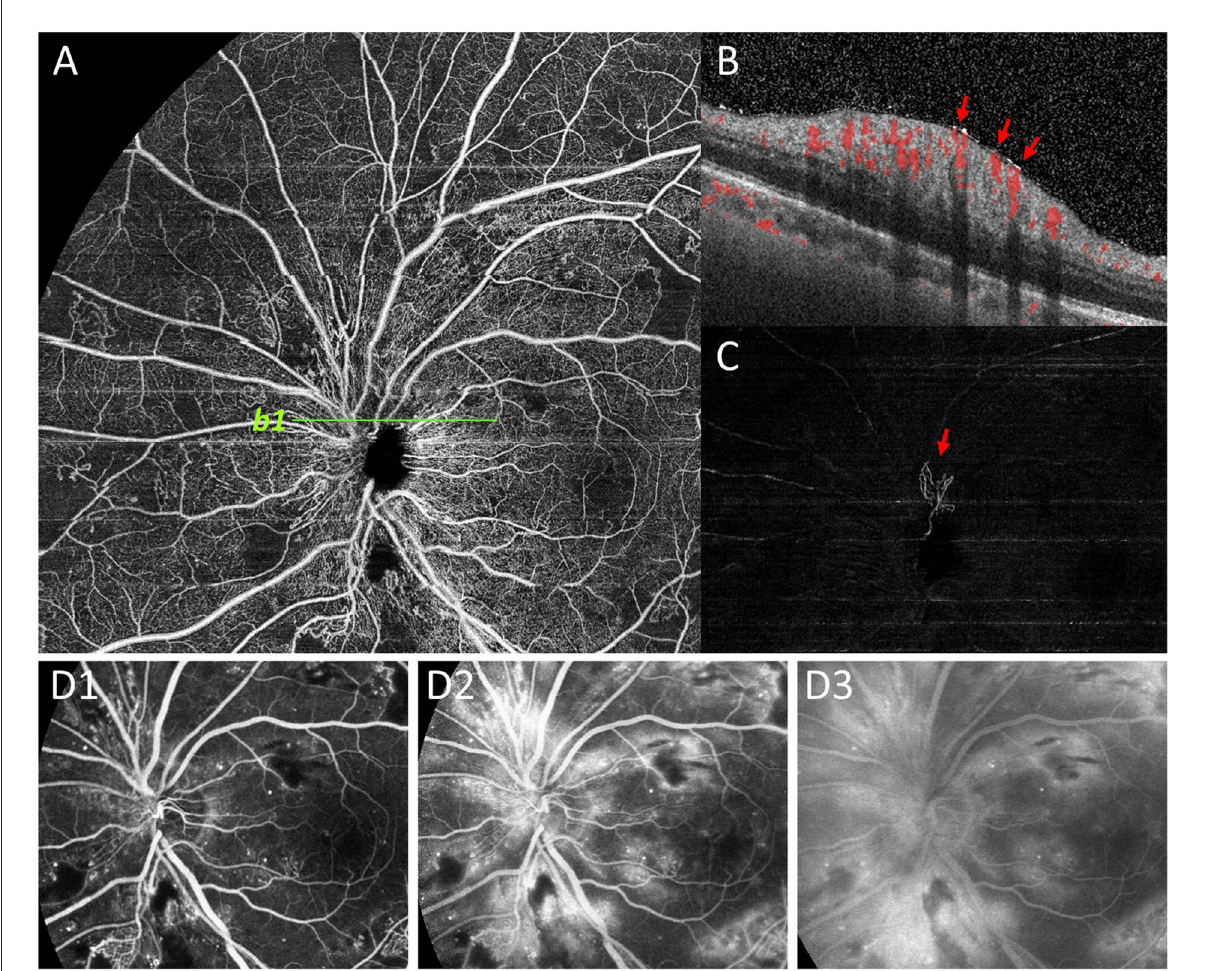
FIGURE5 Representative image to show undetected NVD by FFA. NVD was not clearly shown on superficial retinal segmentation of OCTA (A) . However, the NVD (red arrow) on the upper edge of the optic disc was clearly shown on the vitreous segmentation (C) , and the presence of NVD was also confirmed by B-scan ( b1 , B) . On the contrary, due to the large amount of fluorescein leakage around the optic disc area by dilated capillaries on FFA images, the background hyperfluorescence affected the observation of NVD